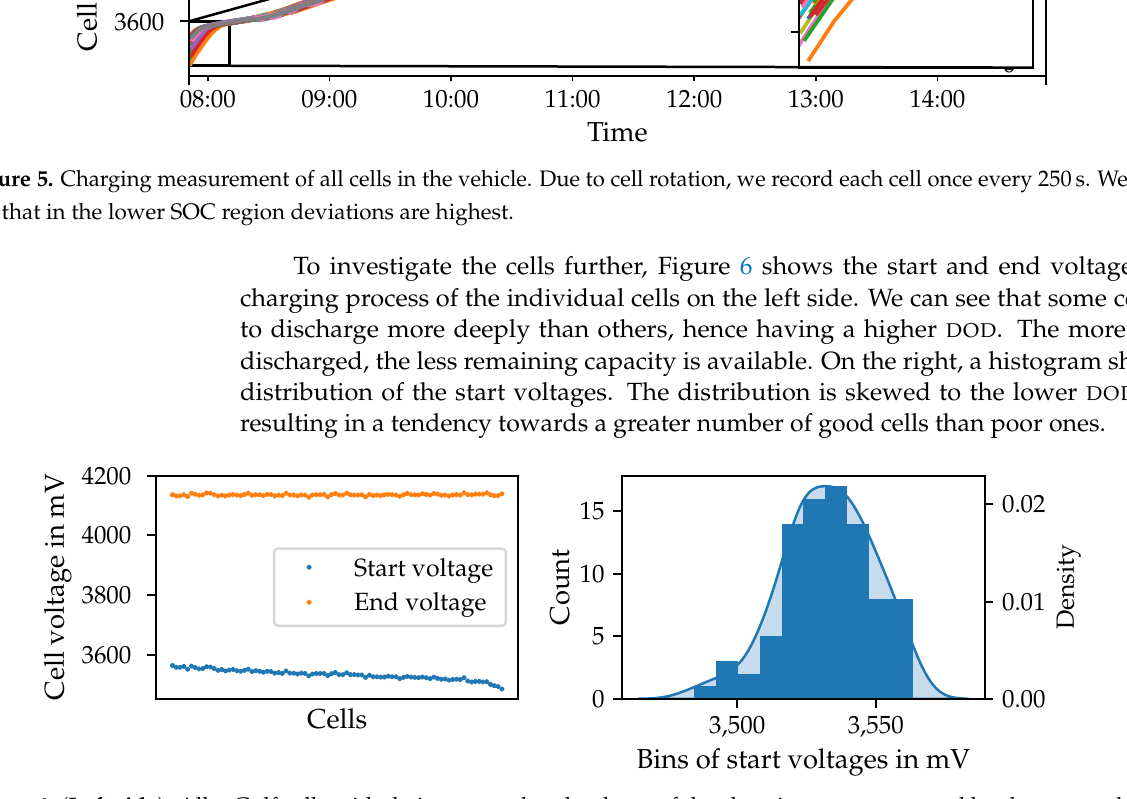
Figure 6. ( Left side ): All e-Golf cells with their start and end voltage of the charging process, sorted by the start voltage. ( Right side ): Histogram of the start voltages. The distribution is skewed to the right, indicating a surplus of cells with lower depth of discharge ( DOD